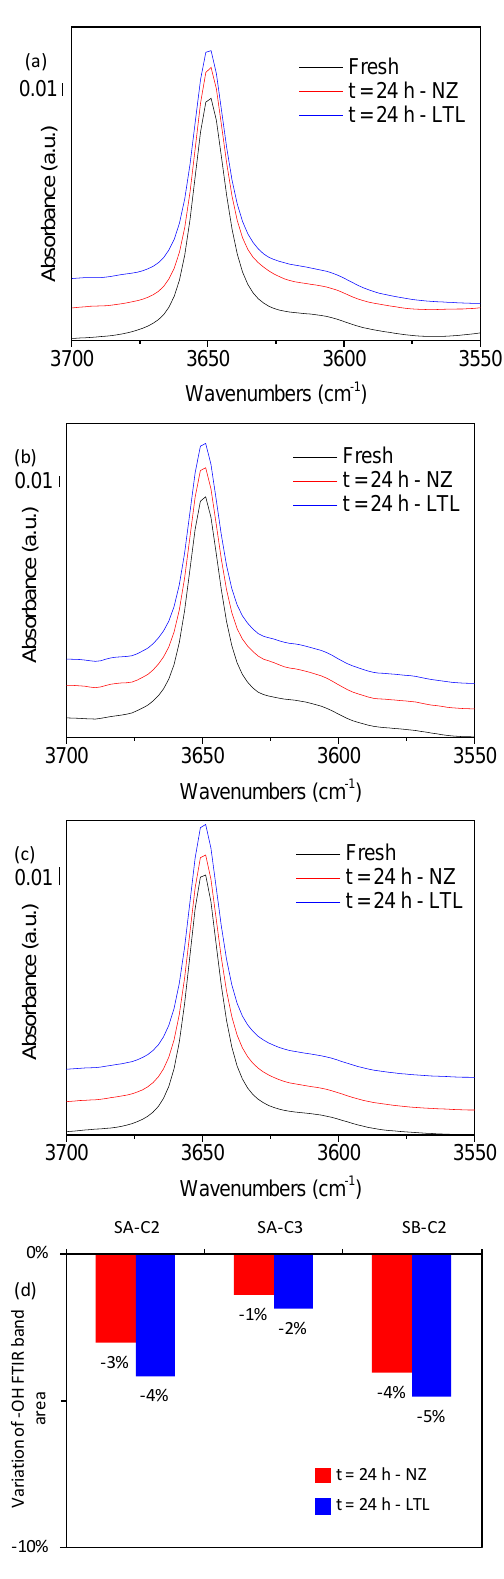
Figure 5. FTIR band vibrations of ( a ) SA-C2, ( b ) SA-C3, ( c ) SB-C2, in their fresh form (black) or following 24 h of oxidation at 150 °C in absence (red) or presence (blue) of LTL nanozeolite. ( d ) Evolution of –OH FTIR band area following oxidation.